Question: Express in one sentence what the figure is showing.
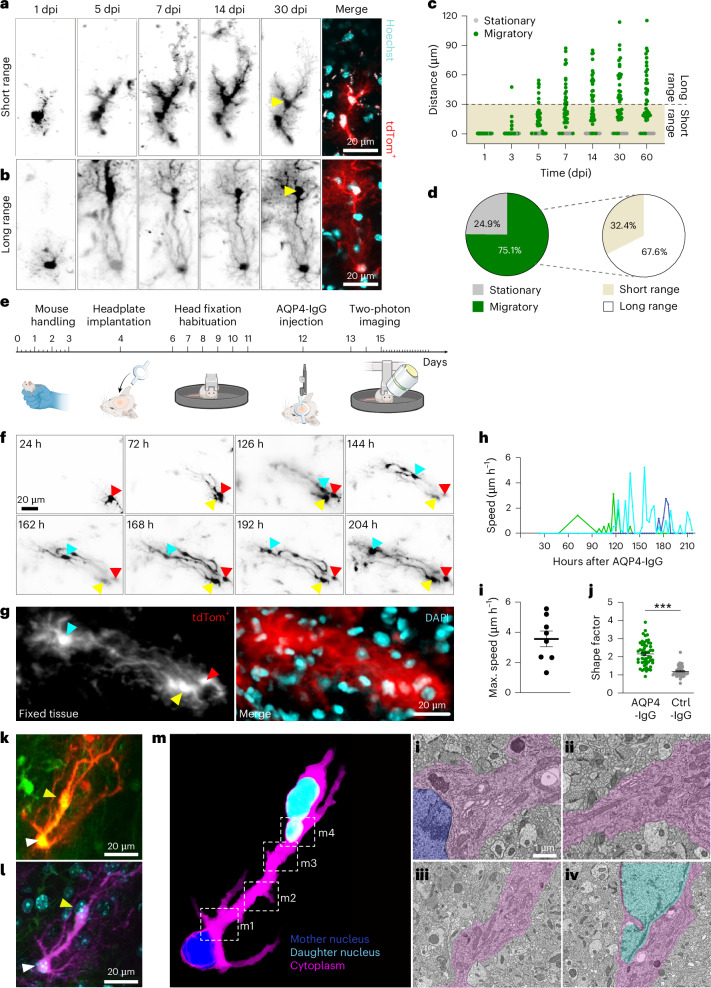
Answer: Multinucleated astrocytes use nucleokinesis for lesion repopulation. a , b , Examples of tdTom + astrocytes undergoing mitosis followed by short-range ( a ) or long-range ( b ) translocation of daughter-cell nuclei (yellow arrowheads). Nuclear counterstaining is shown at last imaging time point (30 dpi) with Hoechst 33342 in vivo. c , Distance of adult-born astrocyte nuclei from their mother cells over time ( n = 61 cells from six mice). Dashed line indicates the threshold for short-range and long-range displacement. d , Frequencies of different behaviors of proliferating astrocytes (data from c ). e – j , High-frequency time-lapse imaging in awake mice revealing saltatory movement of adult-born astrocytic nuclei. Experimental workflow ( e ). f , Time lapses of an individual perilesional astrocyte (red arrowhead; Supplementary Video 3 ), showing its remodeling and proliferation, giving birth to two progenies (cyan and yellow arrowheads). The yellow arrowhead indicates the stationary daughter cell and the cyan arrowhead shows the migratory daughter nucleus. g , The astrocyte from f and its daughter cell are identified in postfixed tissue and counterstained with DAPI. Examples of speed traces of individually tracked astrocytic nuclei ( h ) as well as distribution of speed maxima ( i ; n = 7 nuclei from four mice; thick black line represents mean, and thin black lines represent s.e.m.). h , Cyan-colored lines indicate the nuclei shown in cyan in f . The elongated shape of the nucleus during nucleokinesis ( f ) is noted. j , Change in nuclear shape in astrocytes 5 dpi in AQP4-IgG-IgG ( n = 52 nuclei from five mice) and Ctrl-IgG-injected areas ( n = 48 from four mice) in fixed tissue. *** P < 0.001; Mann–Whitney test, two sided. Data are represented as mean ± s.e.m. k , In vivo two-photon z -projected stack of a repopulating astrocyte (white arrowhead) with translocated daughter nucleus (yellow arrowhead) 10 days after AQP4-IgG injection. l , Two-photon image of the cell